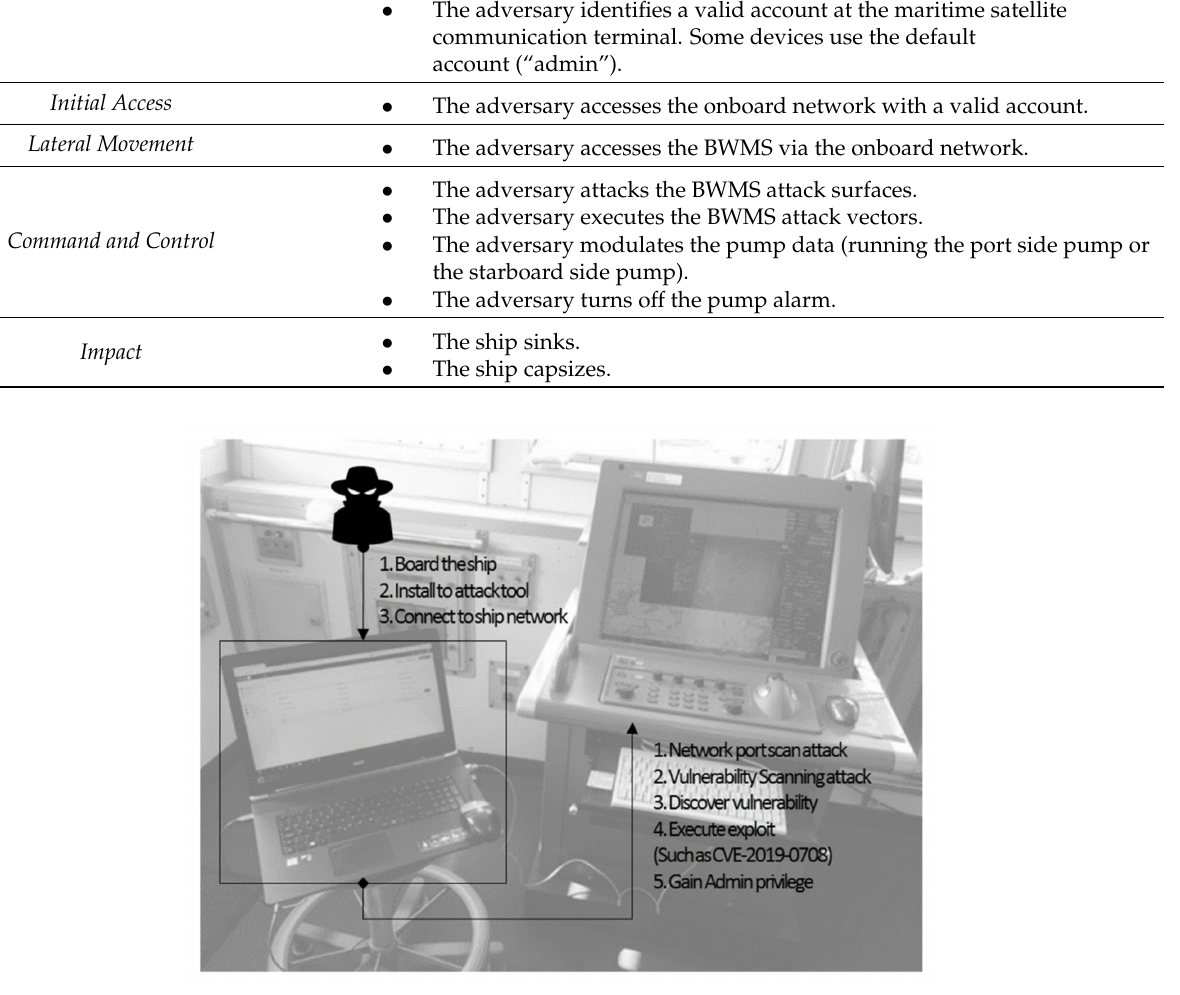
Figure 3. Scenario of attack case